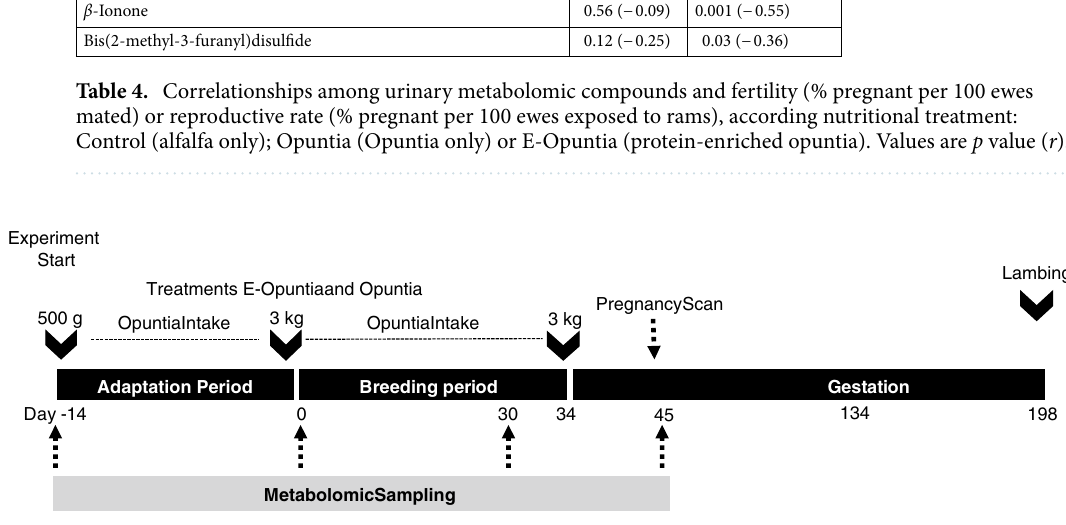
Figure 6. Schema of the experimental protocol. Males were introduced on Day 0 and removed on Day 34. From Day − 14 to Day 0, the female sheep in the E-Opuntia and Opuntia nutritional treatments were allowed to adapt to Opuntia, with the amount offered increasing from 500 g to 3 kg per day. During both the adaptation and breeding periods, sheep in the control treatment received alfalfa at 3% of DM of their body